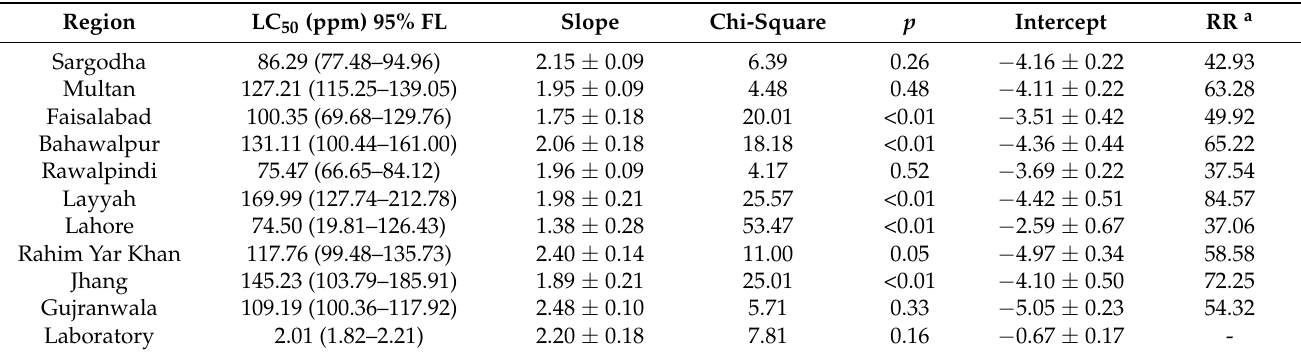
Table 4. Probit analysis of mortality for 10 field-collected populations and a laboratory-susceptible population of Trogoderma granarium adults after 20 h of exposure to phosphine. In all cases DF =